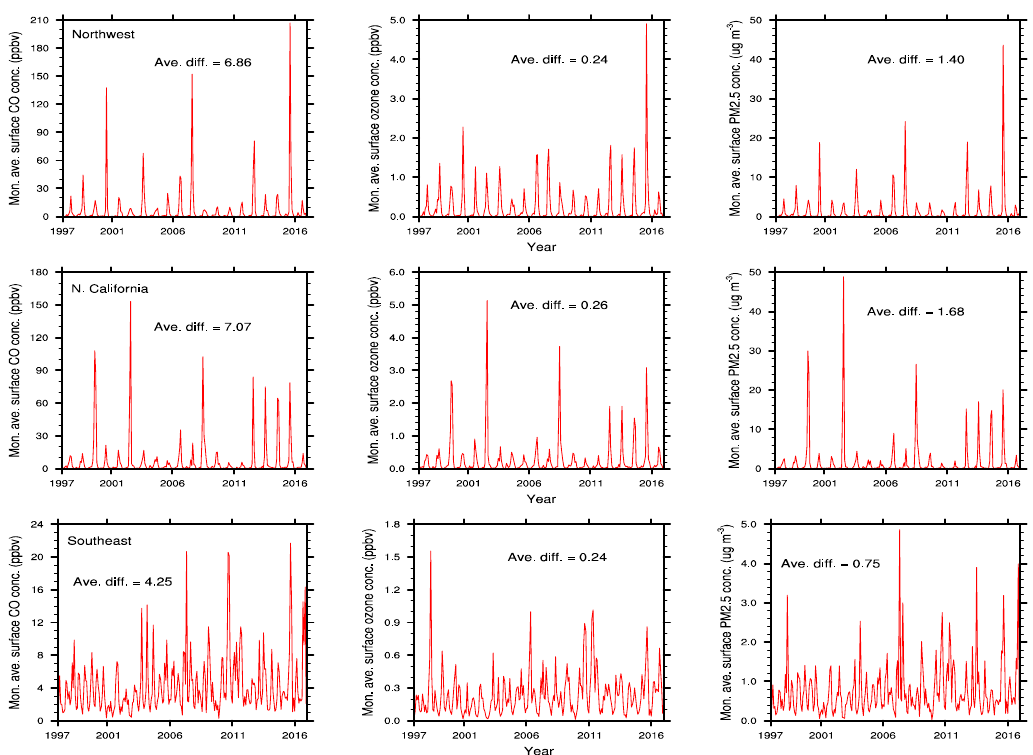
Figure 6. Evolutions of fire contributions to monthly average surface CO (ppbv), O 3 (ppbv), and PM 2.5 ( µ g m − 3 ) for the northwestern U.S., Northern California, and the southeastern U.S. from 1997 to 2016.